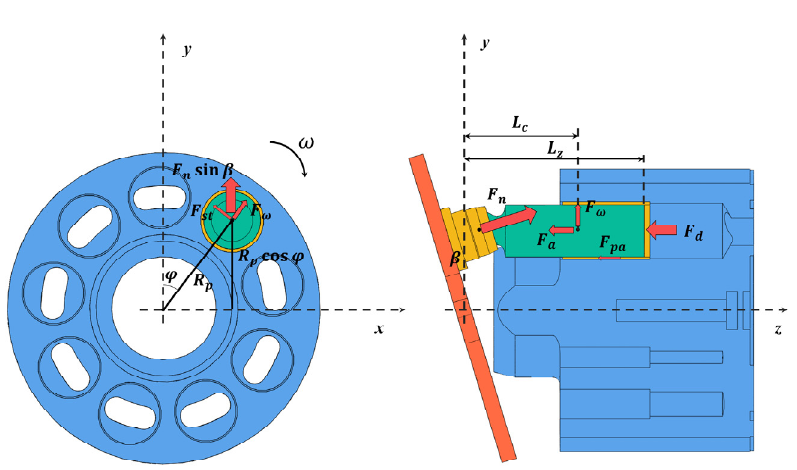
Figure 8. The motion of the piston and forces exerted on the piston.